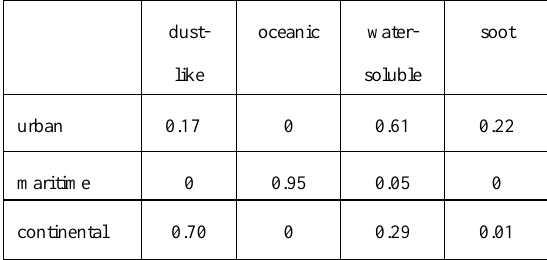
Table 2. The volumetric mixing ratio of the four